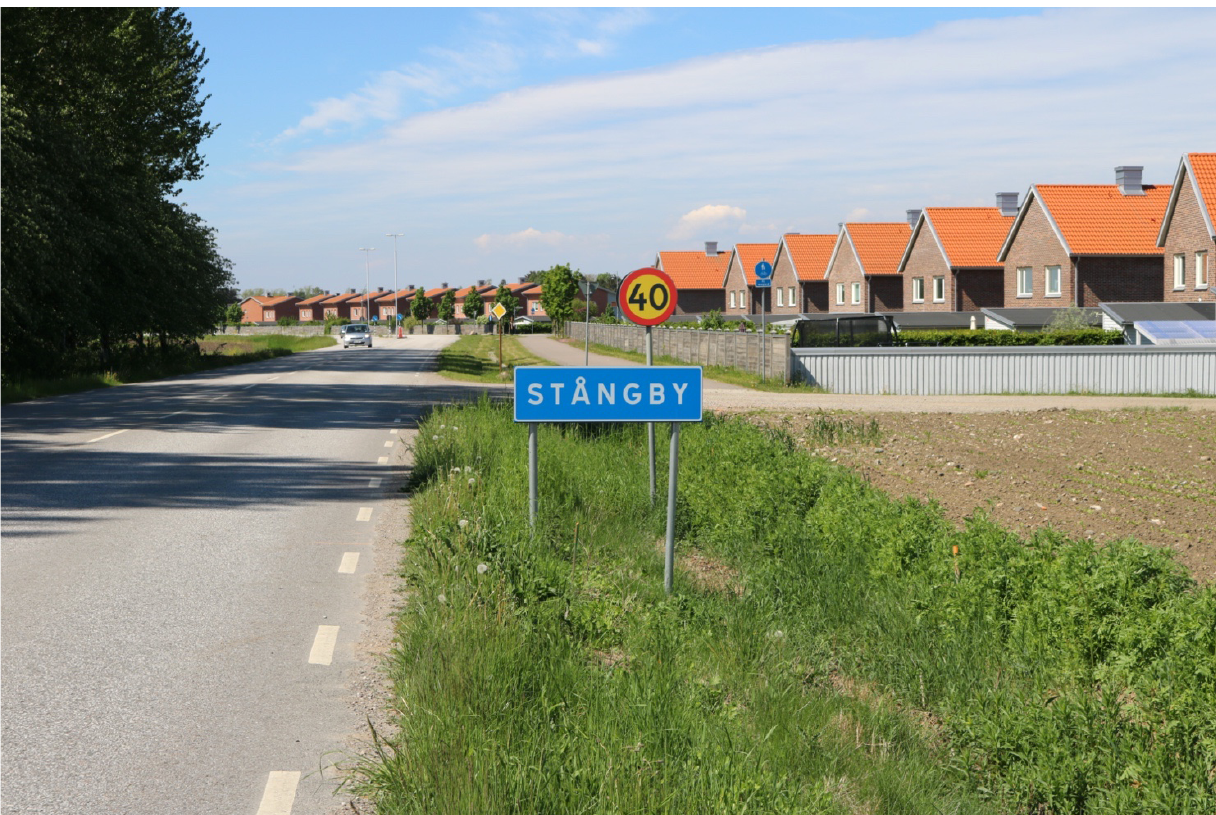
Figure 1. The view from the north entrance to Stångby. Source: